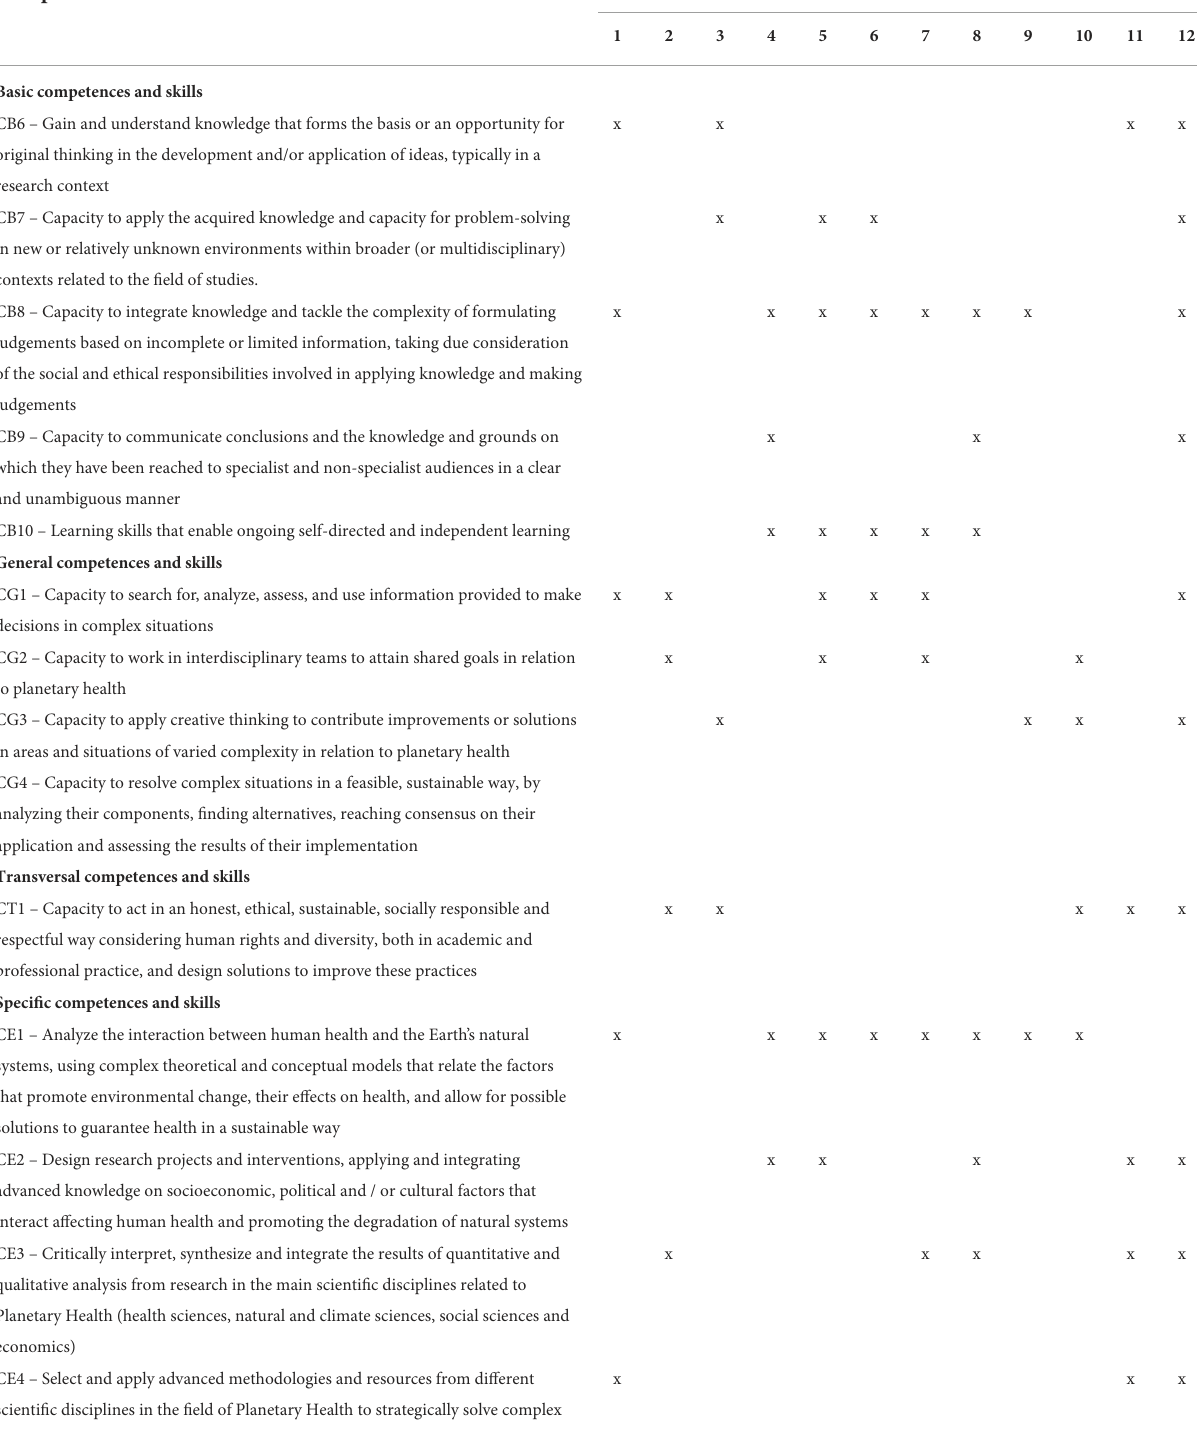
TABLE 2 Distribution of competences and skills across the modules of the programme. Competences and skills